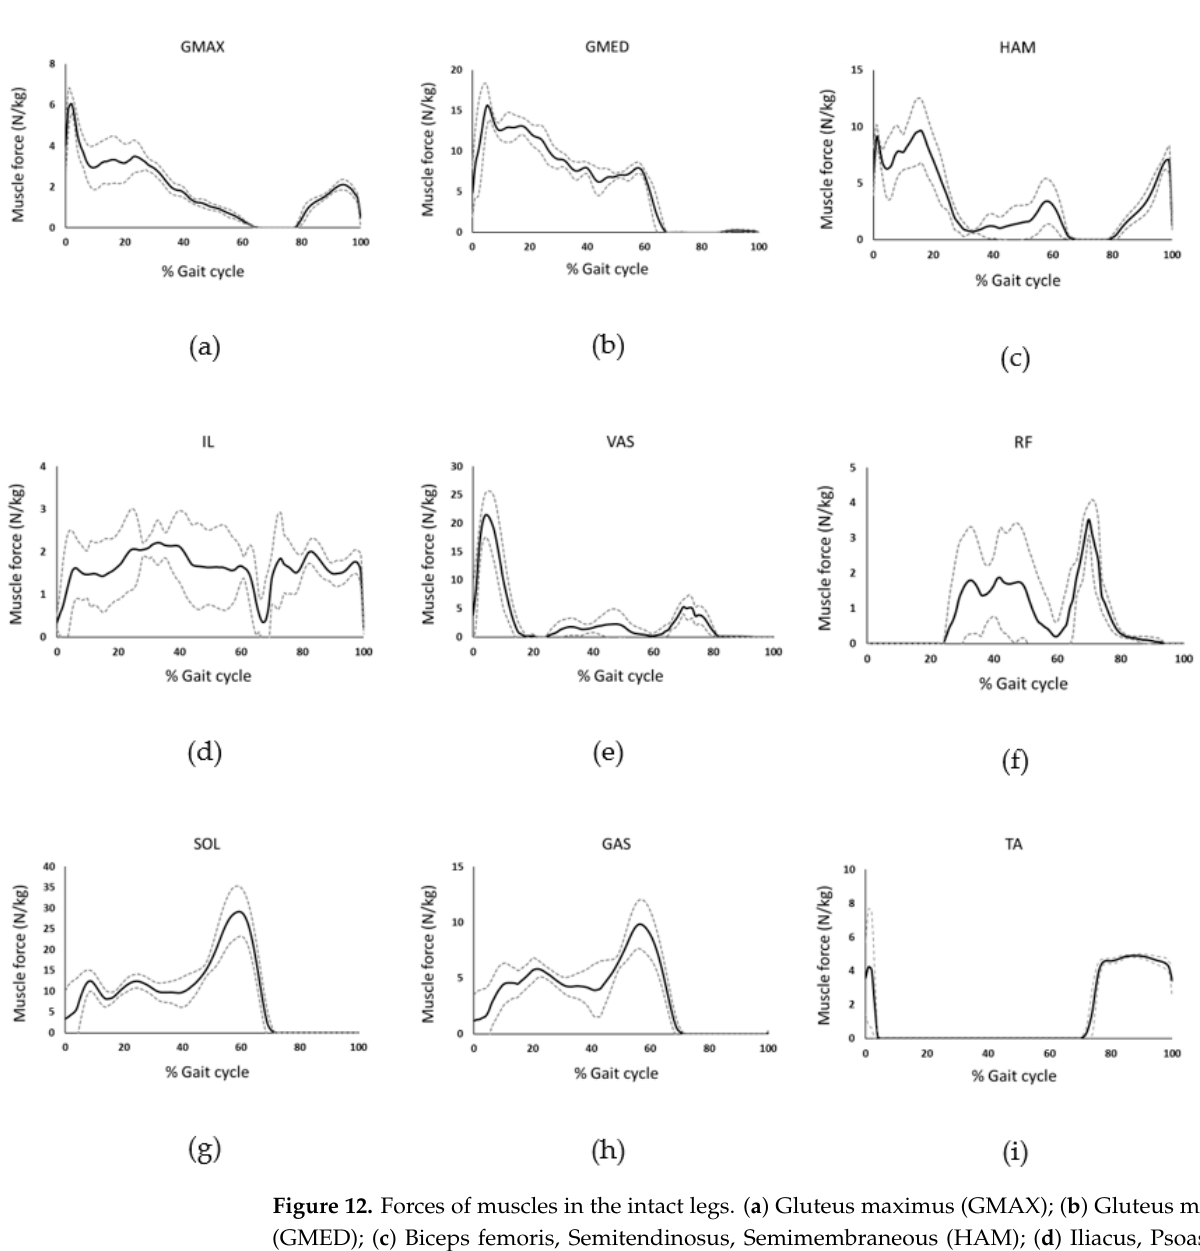
Figure 11. Moments of the ( a ) hip, ( b ) knee, and ( c ) ankle joint of the intact leg. The solid and dashed lines indicate the mean values and standard deviations, respectively. Positive values in the moments indicate hip flexion moment (Flex.), knee extension (Ext.), and ankle plantar flexion moment (P.F.).